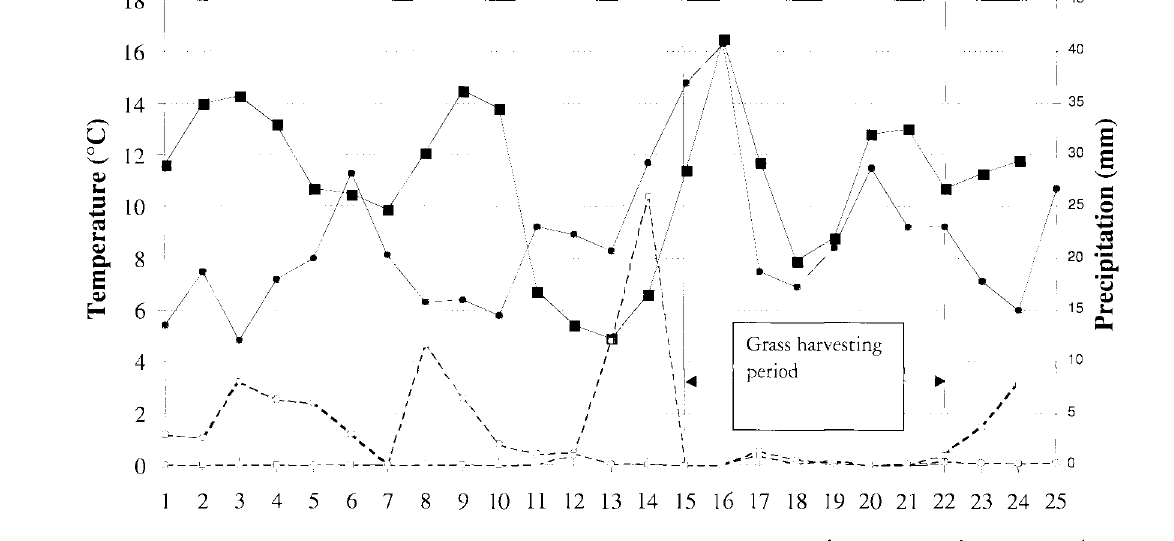
Fig. 3. Mean daily temperature and precipitation during the grazing period (7th of June to 1st of July in 1996 and 14th of June to 7th of July in 1997) at Reinøya. Day 1 represents the start of the grazing period. Temperature for 1996 -#-, 1997 -É-; Precipitation for 1996 -Q- and 1997 -E-.